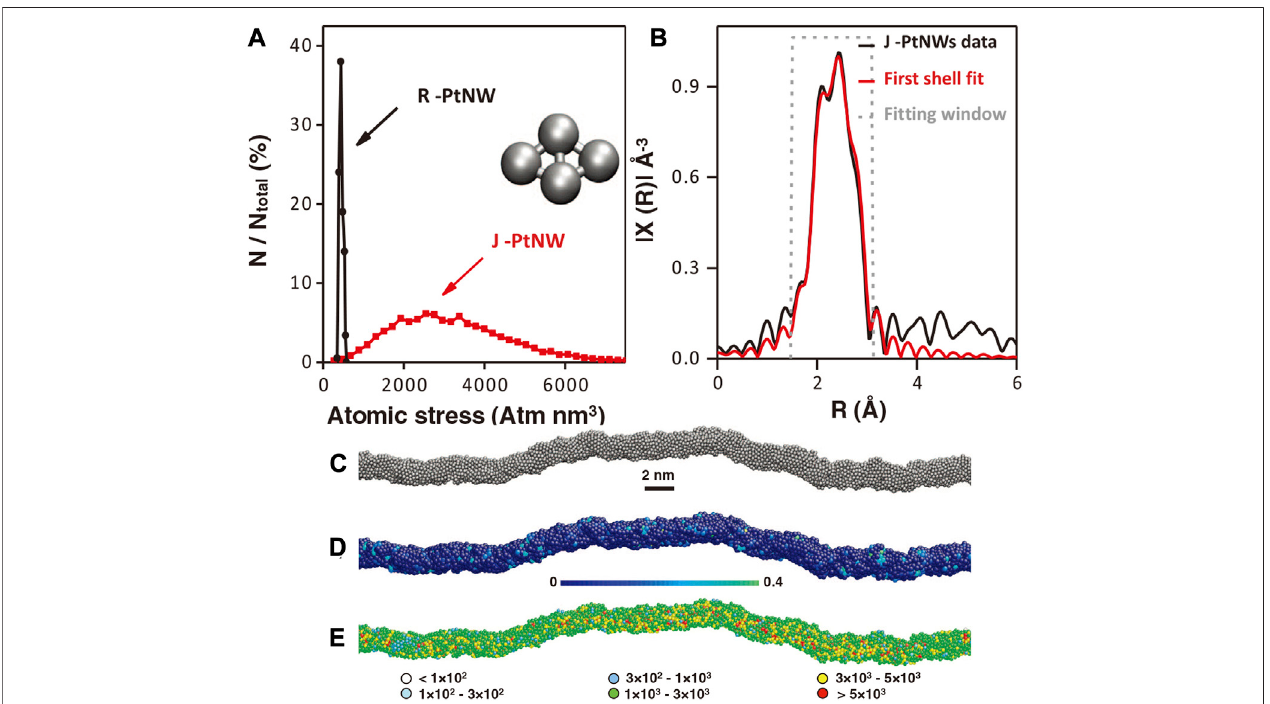
FIGURE 17 | (A) Distribution of absolute value of average atomic stress on Pt NWs surface rhombus structure. (B) Pt-L 3 edge EXAFS of J-Pt NWs. (C) The simulated J-Pt NWs structure through molecular dynamics simulations. (D) J-PtNW with colored atoms to show the fi ve-fold index. (E) Different colored atoms show different absolute values of local stress in J-Pt NWs. Reproduced with permission (Li et al., 2016). Copyright 2016, American Association for the Advancement of Science.